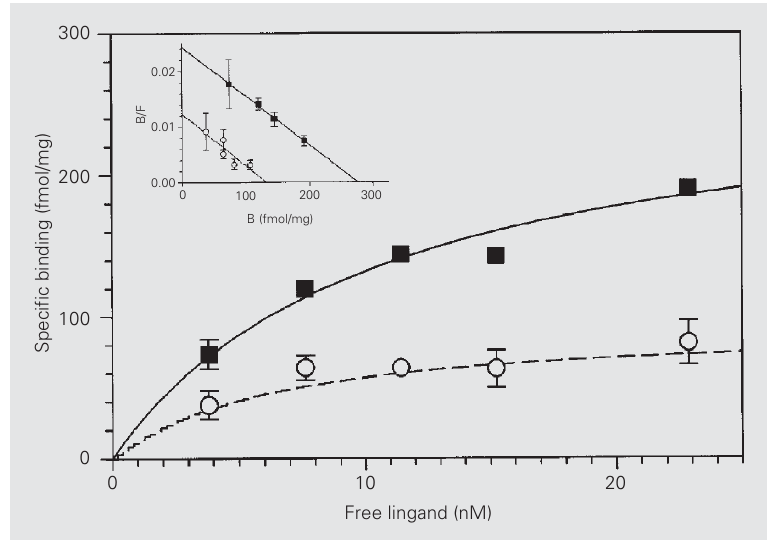
Figure 5. Saturation binding isotherm of [ 3 H]-DHA binding to left ventricle homogenates in sham (squares) and myocardial infarction (MI) rat heart (circles). Inset shows Scatchard analysis of the data. B max was 93.89 ± 20.22 in MI and 271.5 ± 31.43 fmol/mg protein in sham, P = 0.009, nonlinear regression according to rectangular hyperbolic model, N = 3. No significant difference in Kd values was observed between the groups: 10.69 ± 3.78 for MI and 11.37 ± 3.68 nM for sham hearts. The average values were obtained in three duplicate